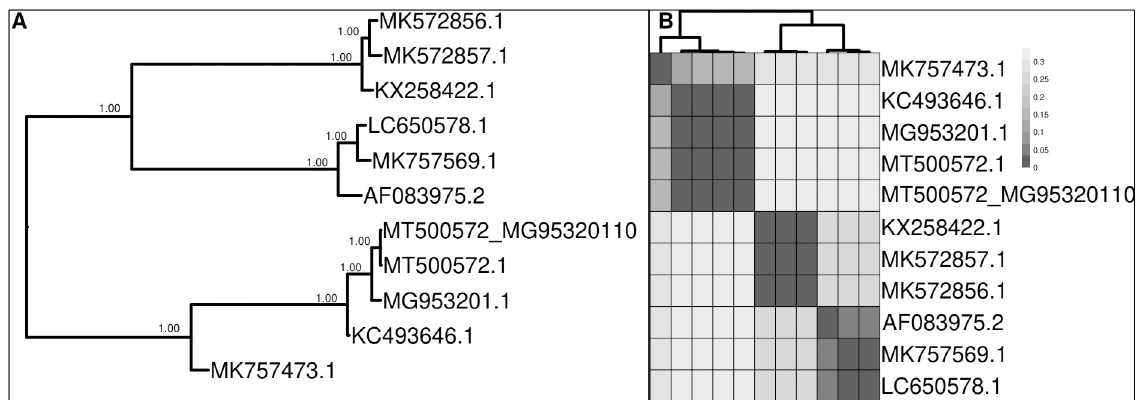
Fig 9. (A) Phylogenetic tree reconstructed for the best 10 BLAST hits using the consensus avian Adenovirus genome obtained using our pipeline and (B) pairwise sequence similarity shown on a heatmap of these sequences using raw distances. The sample name MT500572_MG95320110 represents the sequencing reads genotyped with our pipeline relying on alignments to the reference genome MG953201.1, and MT500572.1 shows the position of the publicly available reference genome of the avian adenovirus isolate D2453/1/10-12/ 13/UA